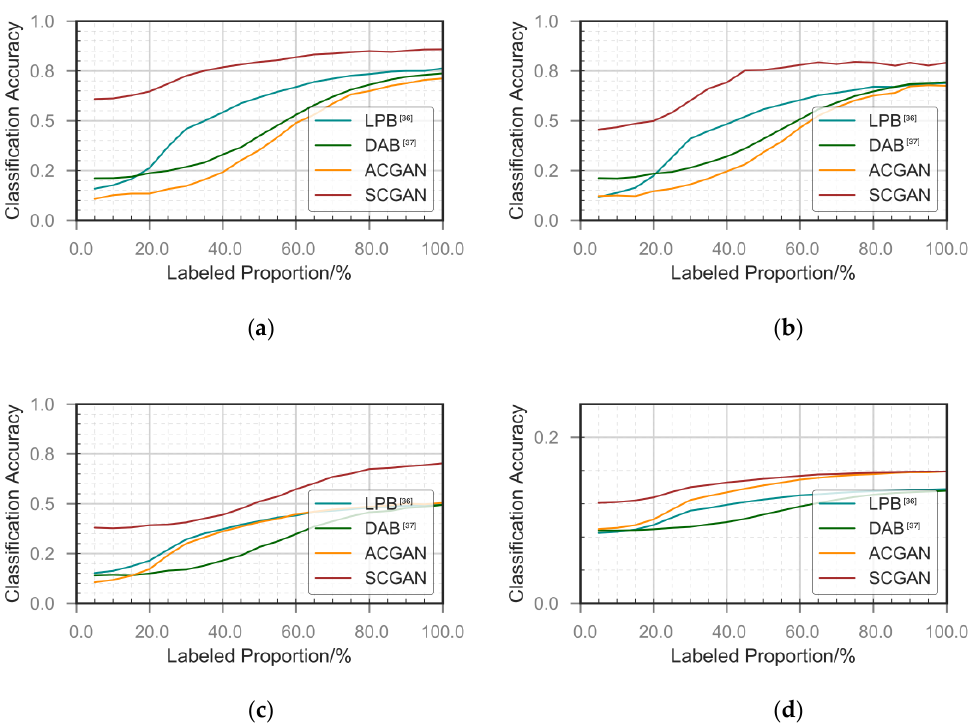
Figure 9. Classification accuracy correspond to: ( a ) 18 dB; ( b ) 5 dB; ( c ) − 5 dB; and ( d ) − 10 dB SNR.